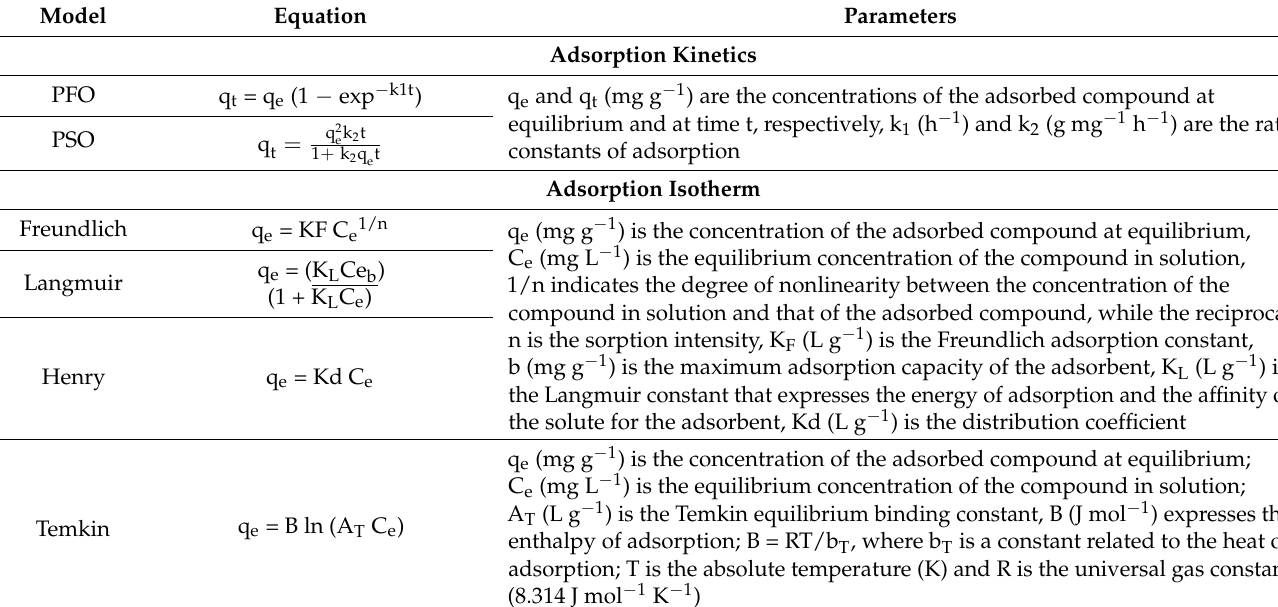
Table 2. Theoretical models